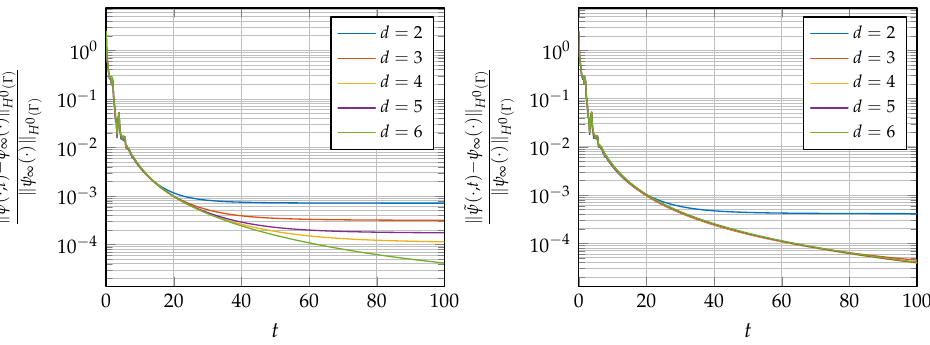
Figure 14. Relative error in H 0 ( Γ ) norm between transient and stationary solution at final time T = 100, versus number of DoFs, having fixed space discretization step ∆ x = 0.2 and time step ∆ t = 0.2.